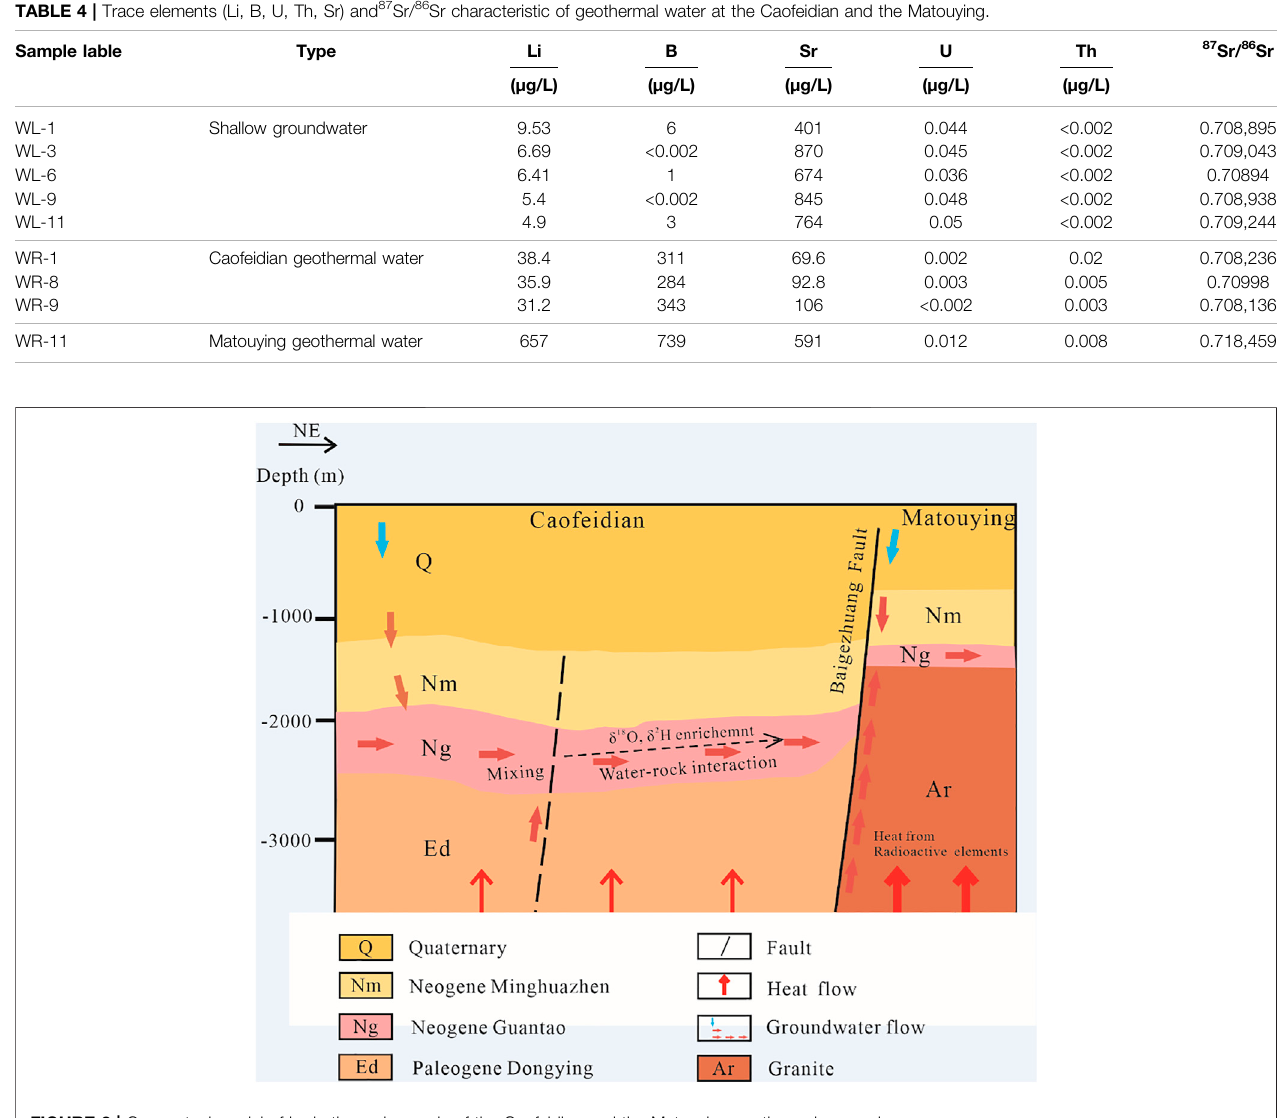
Frontiers in Earth Science |